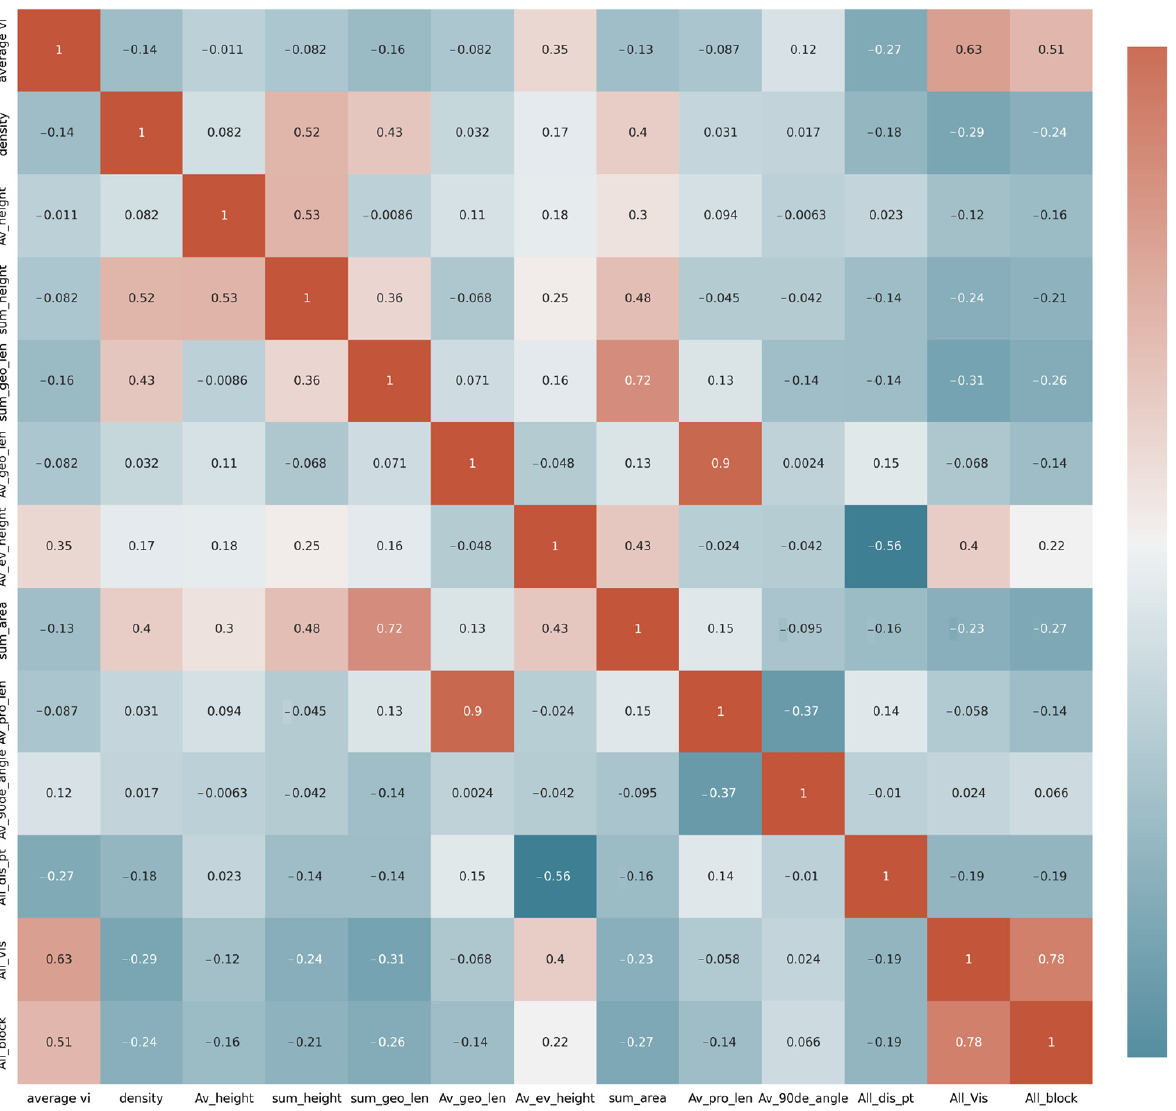
Figure 4. Pearson correlation of the selected variables.